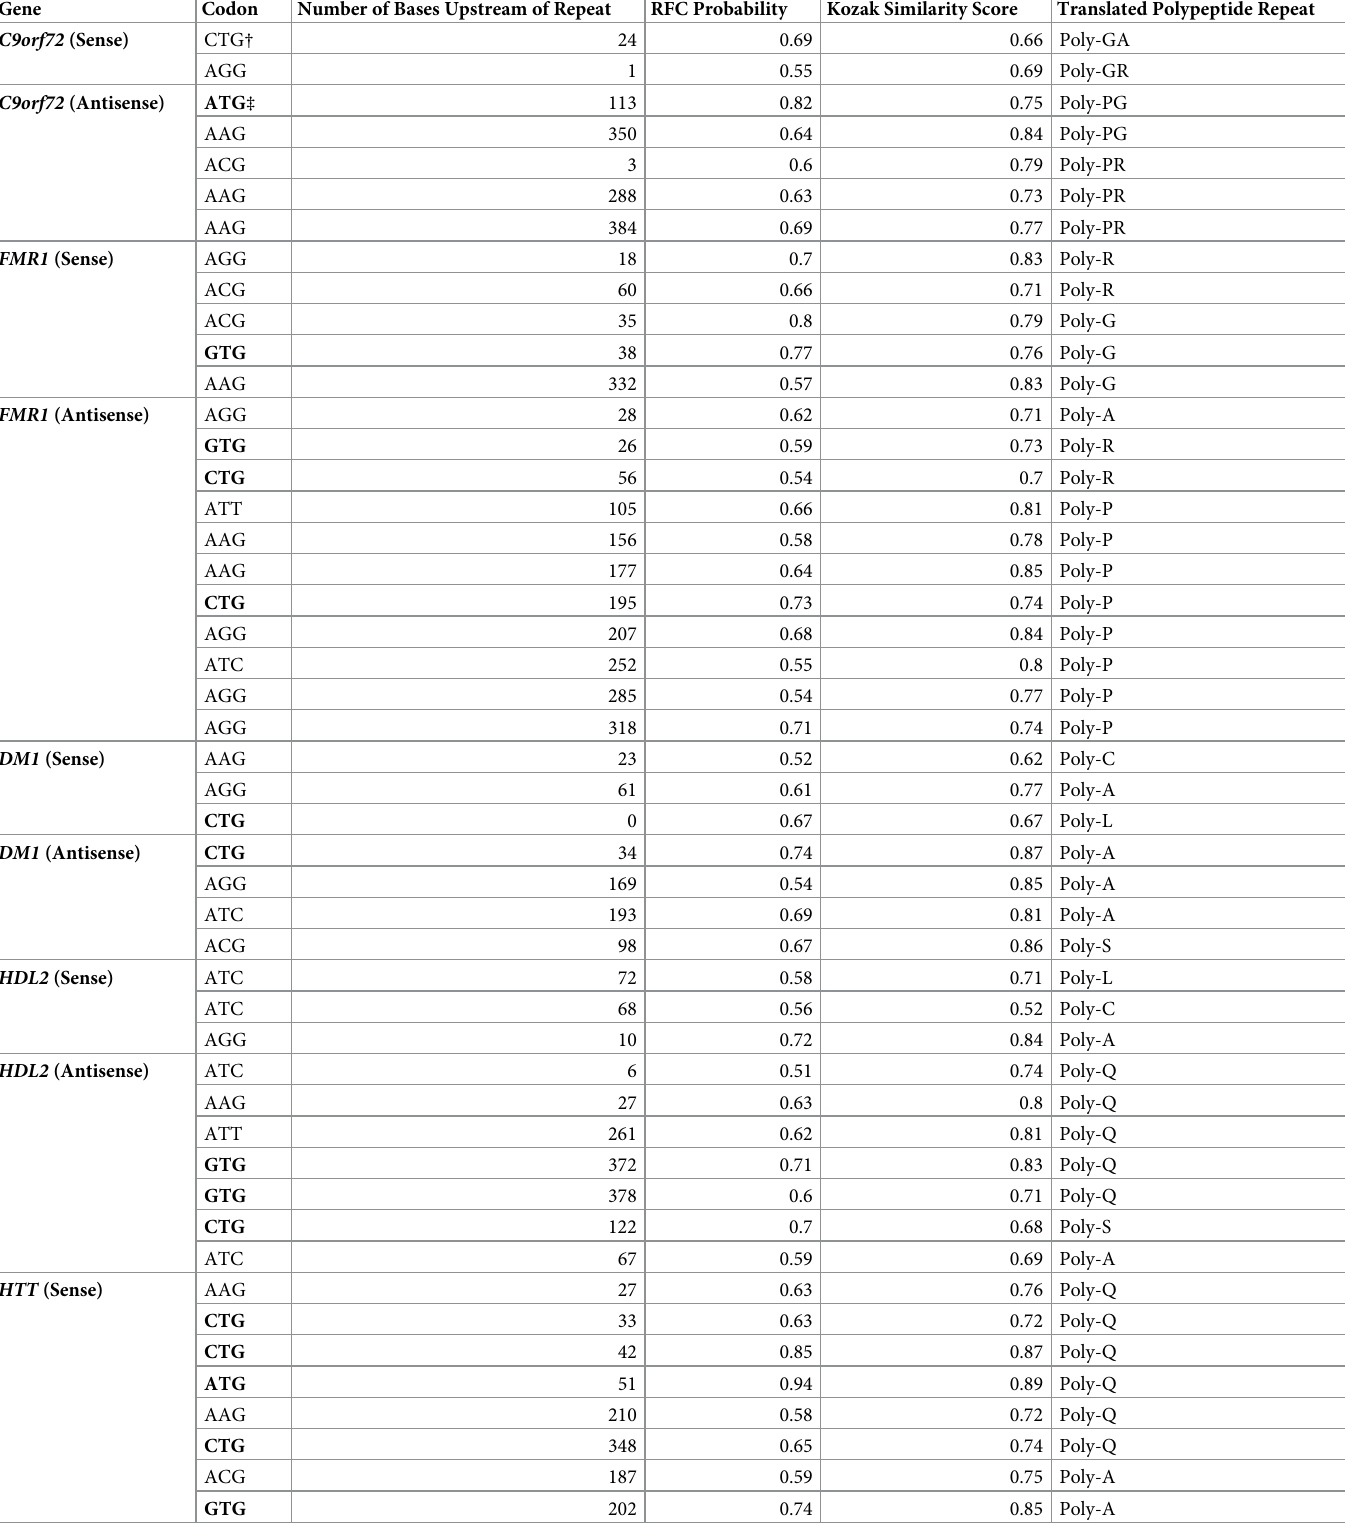
Table 2. Translation initiation codons with high Kozak similarity scores � .